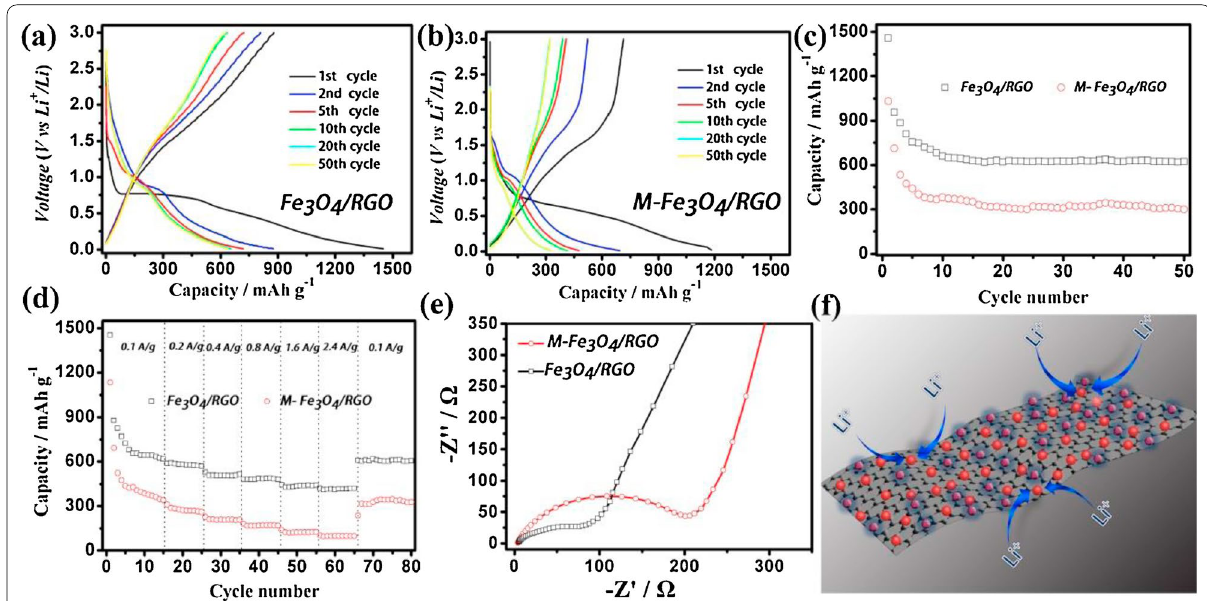
Fig. 11 The charge/discharge curve of Fe 3 O 4 /RGO composites ( a ) and mechanically mixed Fe 3 O 4 /RGO composites (M-Fe 3 O 4 /RGO) ( b ) electrodes at constant current densities of 0.1 A g − 1 . Cycling performance of Fe 3 O 4 /RGO composites and M-Fe 3 O 4 /RGO composites electrode at constant current densities of 0.1 A g − 1 ( c ). Rate capability of Fe 3 O 4/ RGO composites and physically mixed Fe 3 O 4 /RGO composites at the current densities between 0.1 A g − 1 and 2.4 A g − 1 ( d ). Nyquist plots of the electrodes of Fe 3 O 4 /RGO sheet and mechanically mixed Fe 3 O 4 /RGO composites. All of the measurements were conducted using a voltage window of 0.01–3.0 V ( e ). Schematic representation of the electrochemical reaction path on the Fe 3 O 4 /RGO composites ( f ). Reprinted with Permission from [3]. Copyright, Elsevier